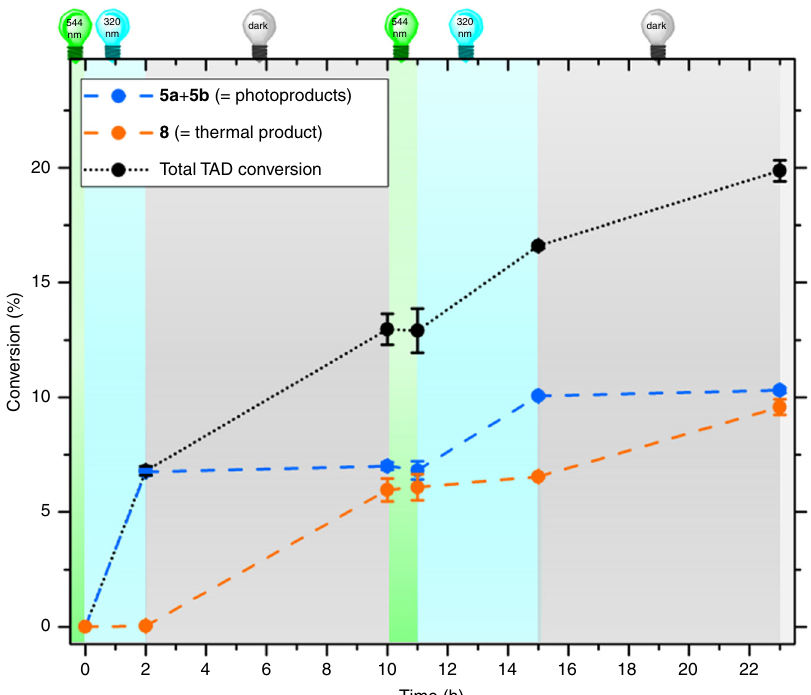
Fig. 6 Switchable outcome of the reaction manifold. Switchable selectivity of the light-driven reaction manifold upon irradiation with UV light (2 h), followed by standing in the dark (8 h) to give photoenol products 5a+5b and thermal addition product 8 , respectively. No TAD conversion is observed during a 1-h period of visible light irradiation, demonstrating the potential to switch off both the photochemical and the thermal TAD reaction channel. A second on/off cycle shows the possibility to re-initiate the system. The yield of the photoproducts 5a+5b , yield of thermal adduct 8 , and the overall TAD conversion were determined via 1 H-NMR (error bars: standard